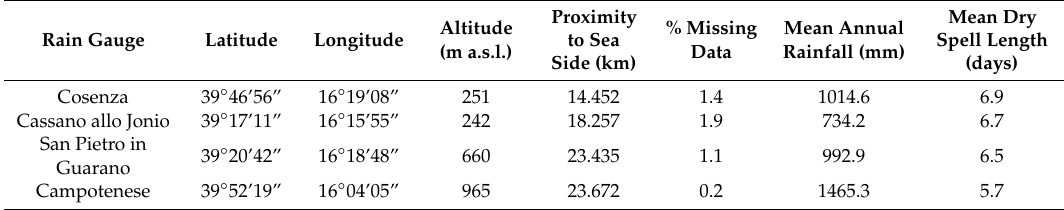
Table 1. Main details of the selected rain